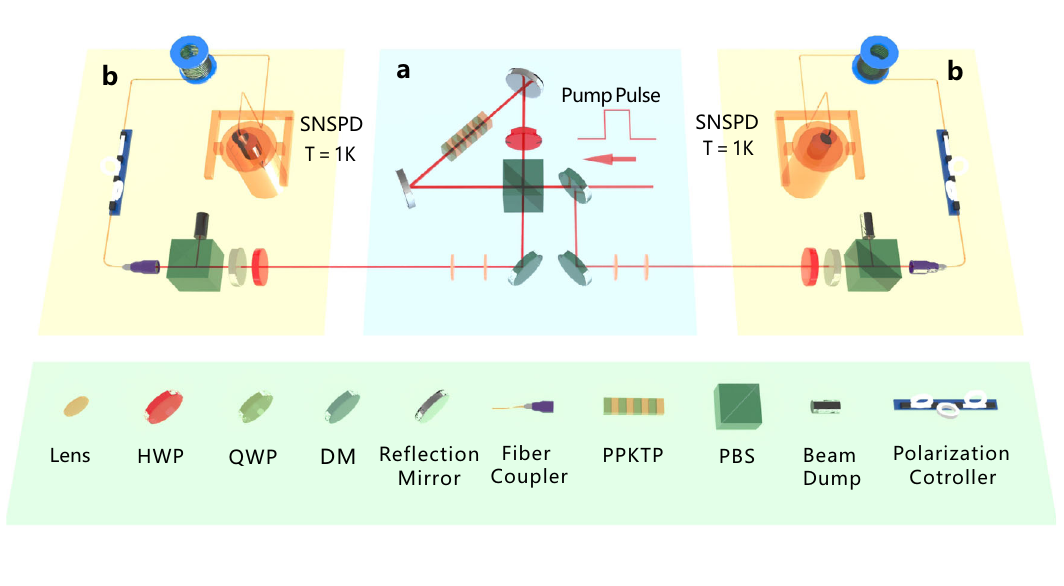
Fig. 4 Schematic of the all-photonic DI-QKD implementation reported in ref. 49 . a Entanglement source. For the creation of pairs of entangled photons, light pulses of 10 ns are injected at a repetition pulse rate of 2 MHz into a periodically poled potassium titanyl phosphate (PPKTP) crystal in a Sagnac loop to generate polarization-entangled photon pairs. The two photons of an entangled pair at 1560 nm travel in opposite directions towards Alice and Bob, where they are subject to polarization projection measurements. b Alice ’ s and Bob ’ s QKD receivers. In her (his) measurement site, Alice (Bob) uses a set of HWP and QWP to project the polarization of the incoming single photons into a pre- determined measurement basis. After being collected into the fi ber, the photons travel through a certain length of fi ber and then are detected by a superconducting nanowire single-photon detector (SNSPD) operating at 1K. HWP half-wave plate, QWP quarter-wave plate, DM dichroic mirror, PBS polarizing beam splitter. Reprinted fi gure with permission from ref. 49 (https://doi.org/10.1103/PhysRevLett.129.050502), Copyright 2022 by the American Physical